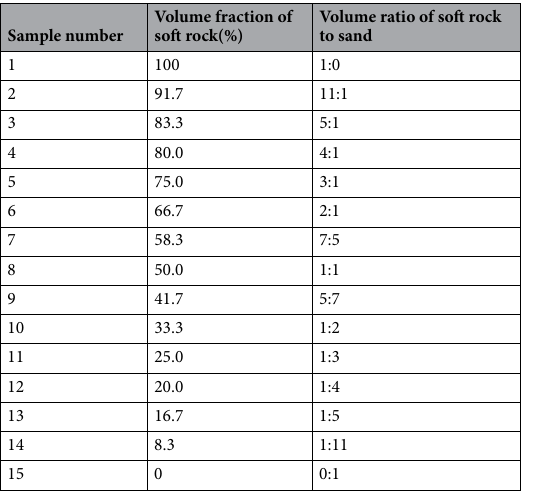
Table 3. Proportion of soft rock and sand in compound